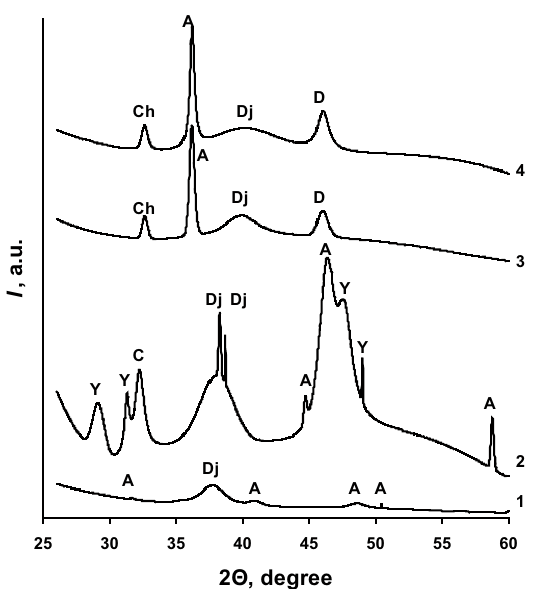
Figure 4. X–ray diffraction patterns of Cu S layers on PA (curves 1 x and 2) and PE (curves 3 and 4) (peaks of djurleite –